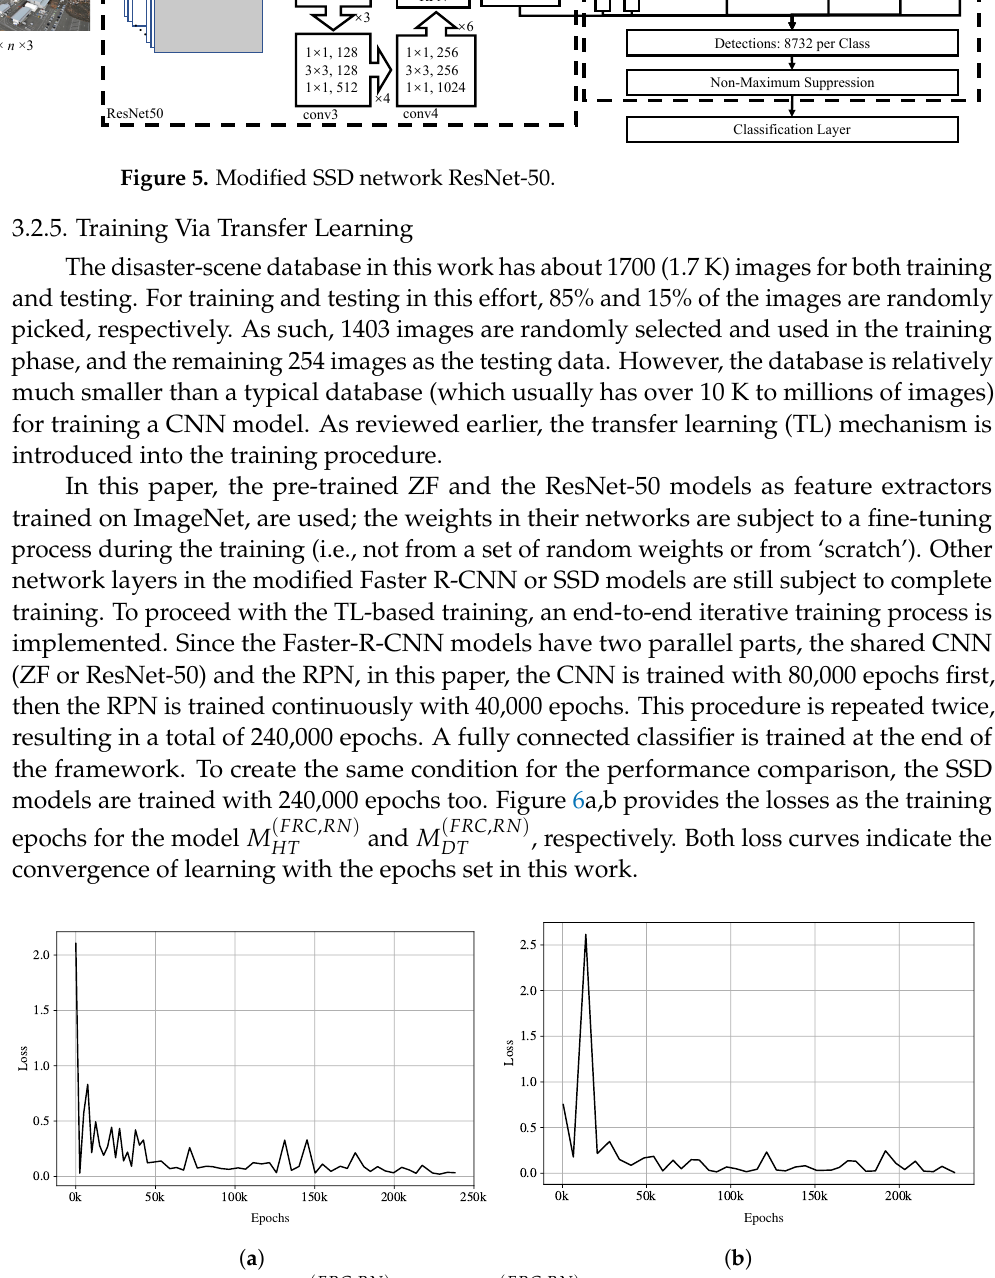
( FRC , RN ) ( FRC , RN ) and ( b ) M HT DL